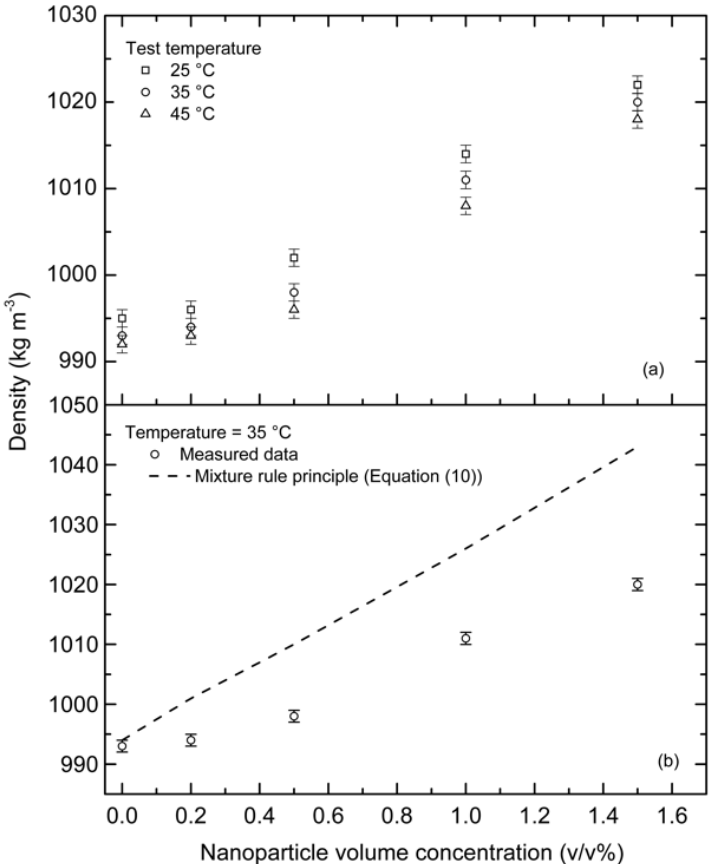
Figure 8. ( a ) Experimental density of TiO 2 –W NFs as a function of temperature and NP volume concentration. ( b ) Comparison of the measured density at 35 °C and that predicted by the mixture rule principle [48].